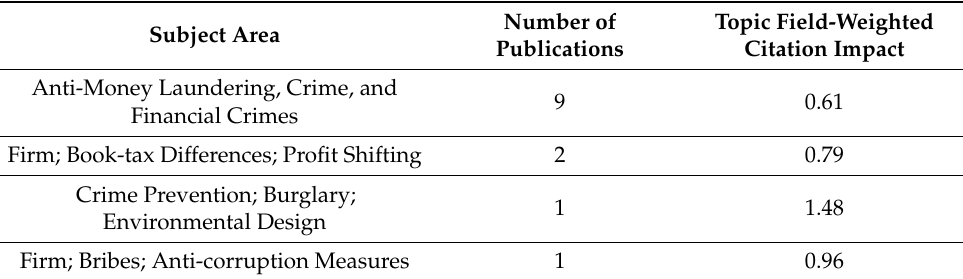
Table 8. Scholarly contributions of Ferwerda, 2017–2021.